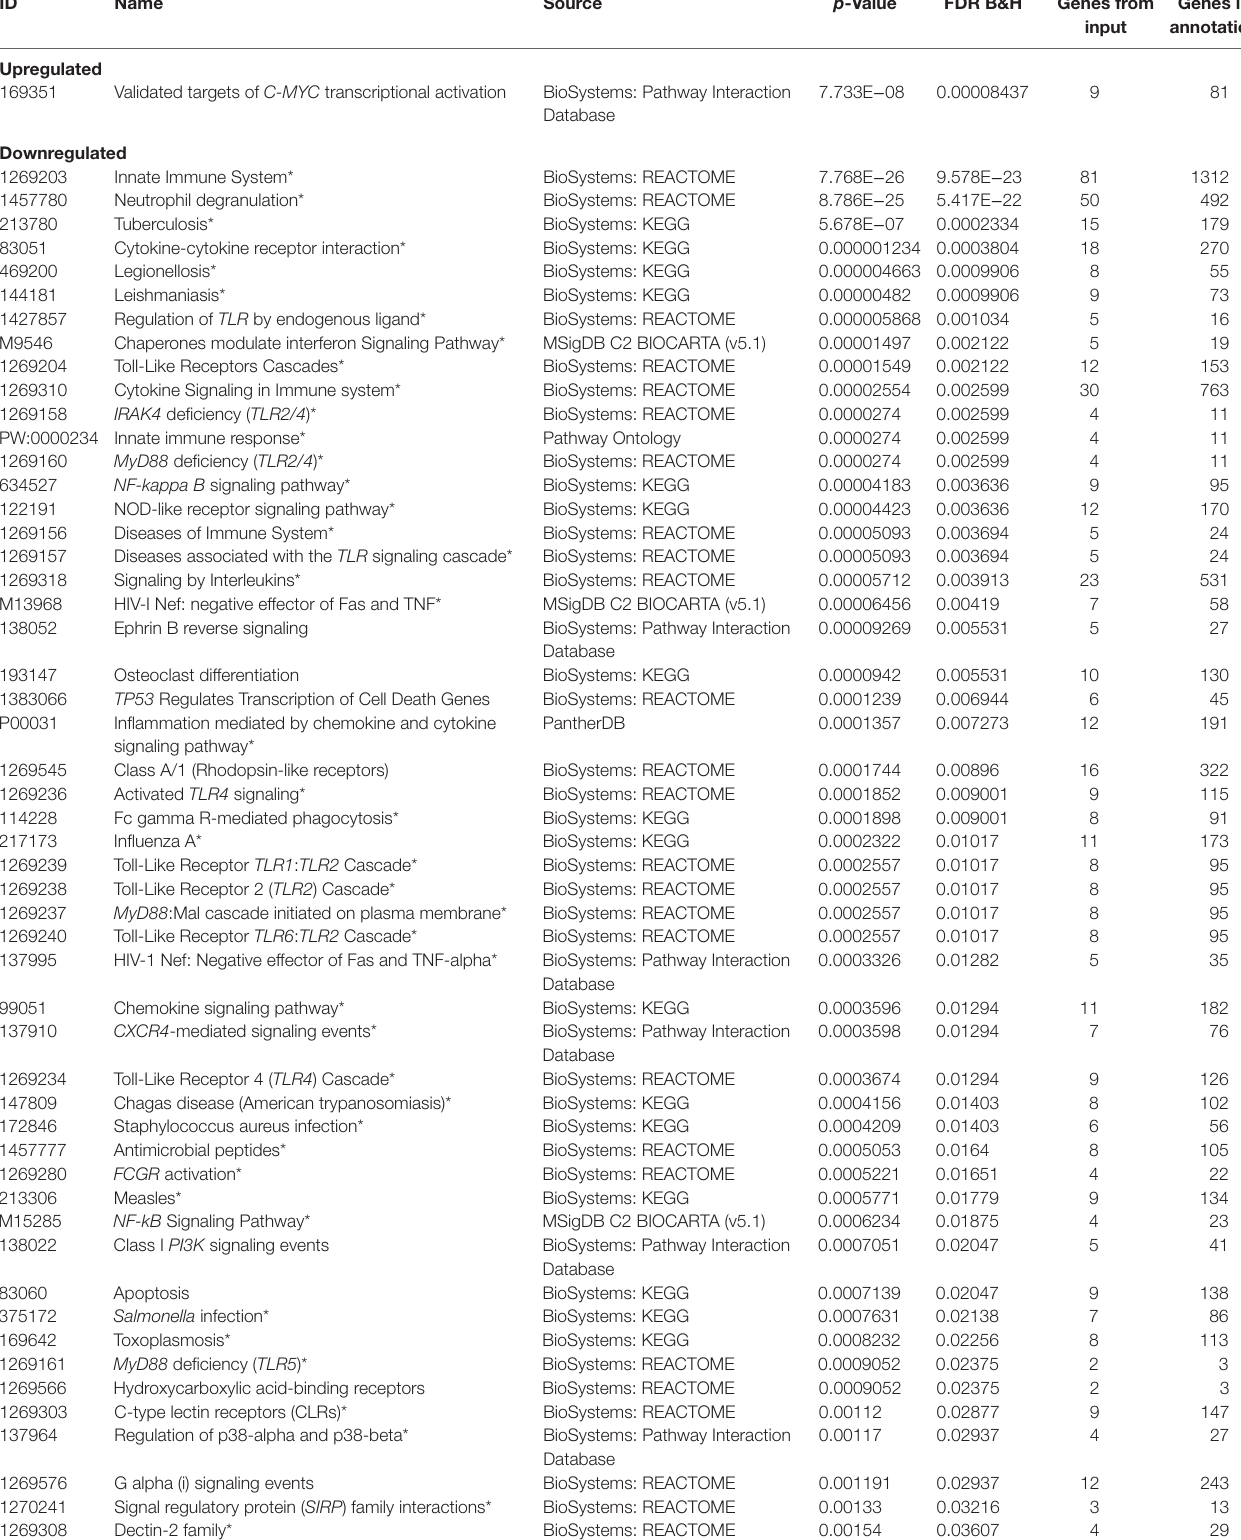
taBle 4 | Functionally enriched pathways from cord blood tissue